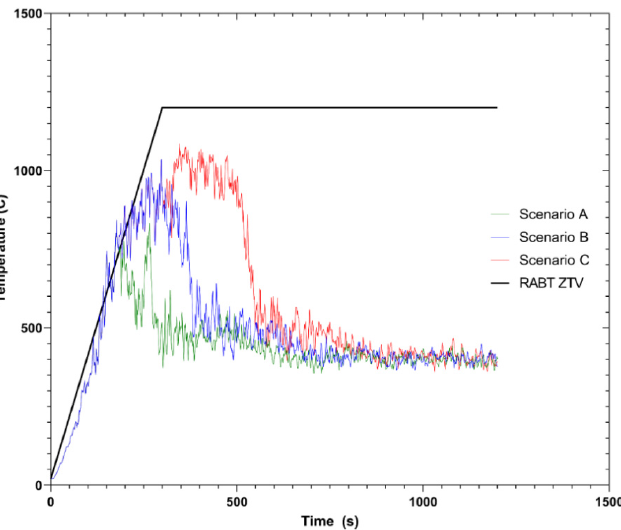
Figure 10. FDS ceiling temperatures above the fire source (x = 795 m, z = 7 m) for all three scenarios in comparison with the RABT ZTV fire curve.